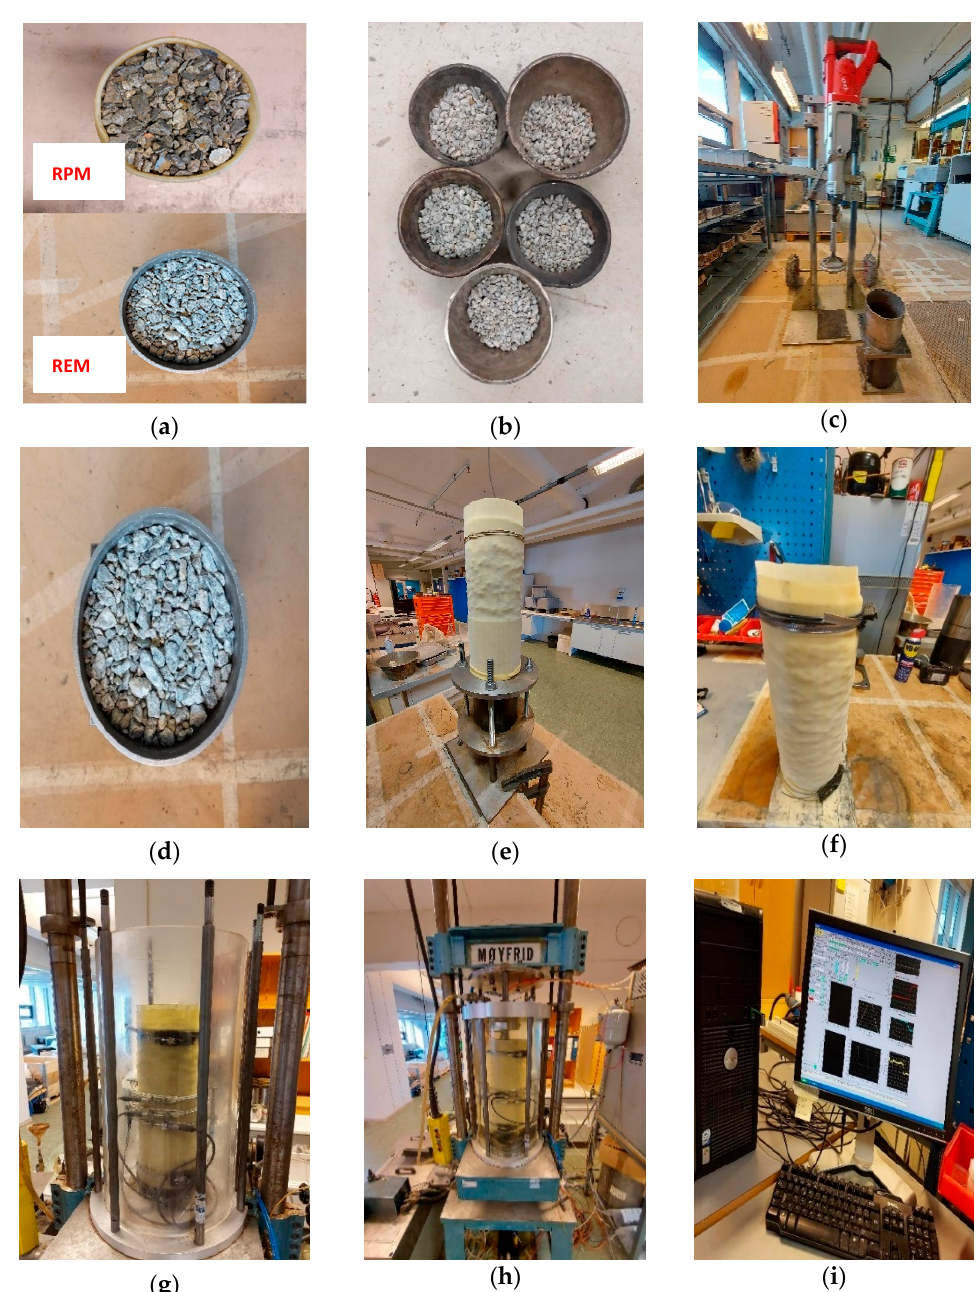
Figure 3. Repeated Load Triaxial Test set up. ( a ) Sample of REM and RPM; ( b ) Sample distribution into five different parts following specific gradation; ( c ) Vibrator hammer for sample compaction; ( d ) Fully compacted specimen in the steel mold; ( e ) Ejected specimen covered with first latex mem- brane; ( f ) Mounting of second latex membrane, plastic rings, and hose clamps; ( g ) Specimen placed in RLTT chamber with mounted two vertical and three horizontal linear variable differential trans- ducers (LVDTs); ( h ) RLTT chamber filled with water and ready to begin test; ( i ) Computer setup for data collection.